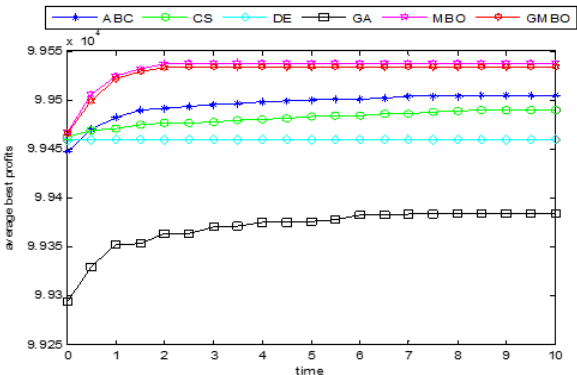
Figure 23. The convergence graph of six methods on KP14 in 10 seconds.